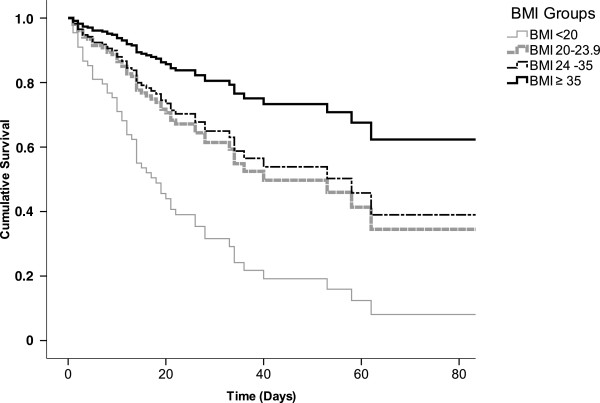
Survival curves stratified by BMI. Kaplan–Meier survival curves stratified by BMI and adjusted for APACHE II scores and HbA1c. BMI <20 vs. 20–23.9 kg/m2, P = 0.032; BMI <20 vs. 24–34.9 kg/m2, P = 0.010; BMI <20 vs. ≥35 kg/m2, P = 0.032.